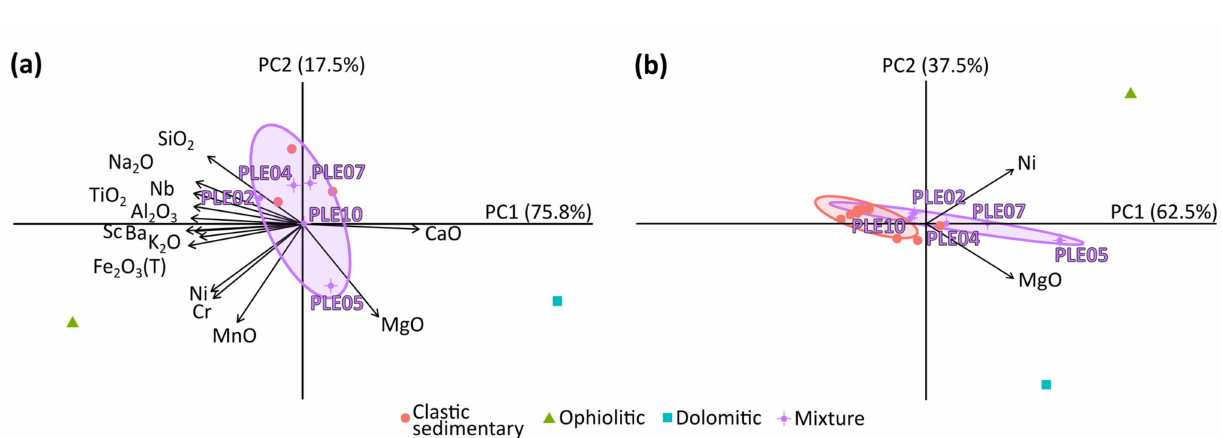
Figure 10. ( a ) Principal component analysis (PCA) of this work’s dataset. In this case, only the range test was applied due to the low number of samples. The sum of the two principal components (PC1 and PC2) was 93.3%. ( b ) Results of PCA using a combination of the dataset presented in this work and [22]. The figure displays the results that were achieved after running the three tests mentioned in the text and with the combination of oxides/elements as suggested by the results